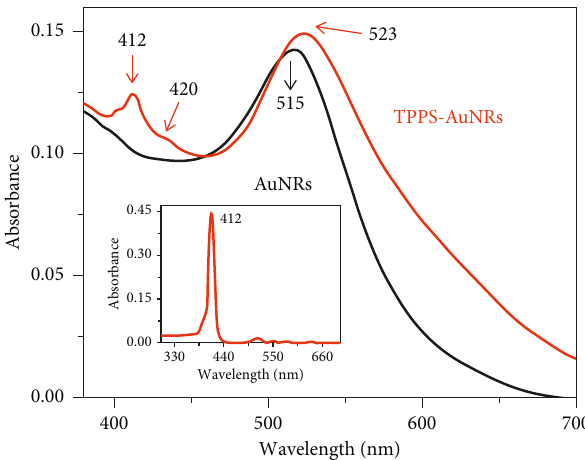
Figure 20: UV-Vis spectrum of TPPS-AuNRs and AuNRs.